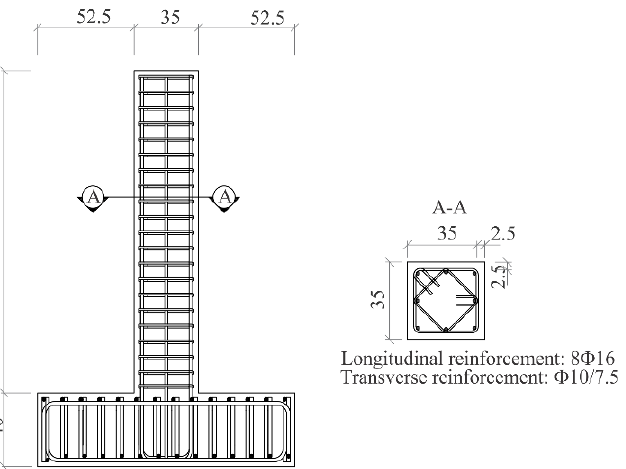
Figure 6. Elevation view of specimen with reinforcement and cross-section of column of specimen reinforced with DPD2. Table 3. Compressive strength ( f c ), corresponding compressive strain at f c ( ε c0 ), ultimate strain ( ε cu ), axial tensile strength ( f ct ), tensile strain at f ct ( ε t ) and elastic modulus ( E c ) of confined and unconfined